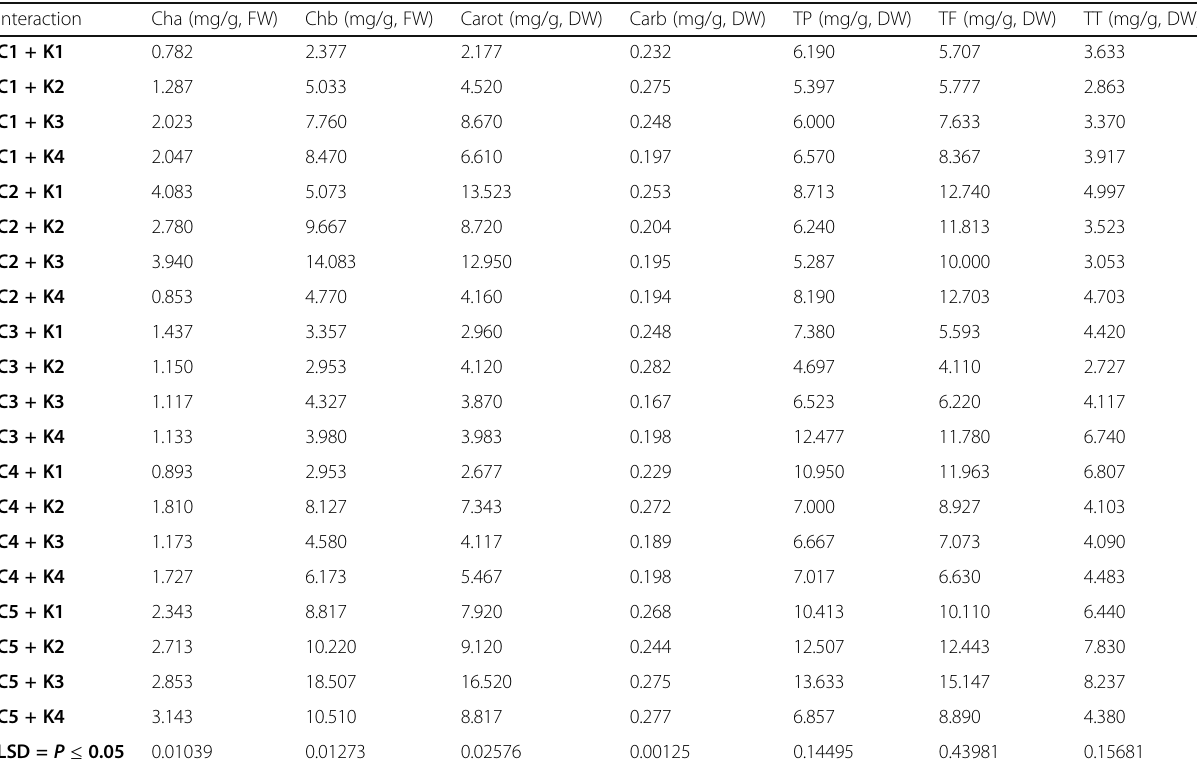
Table 3 Interaction of different cultivars and kinetin treatments affects the chemical analysis of Coleus blunei (mean of two seasons) Interaction